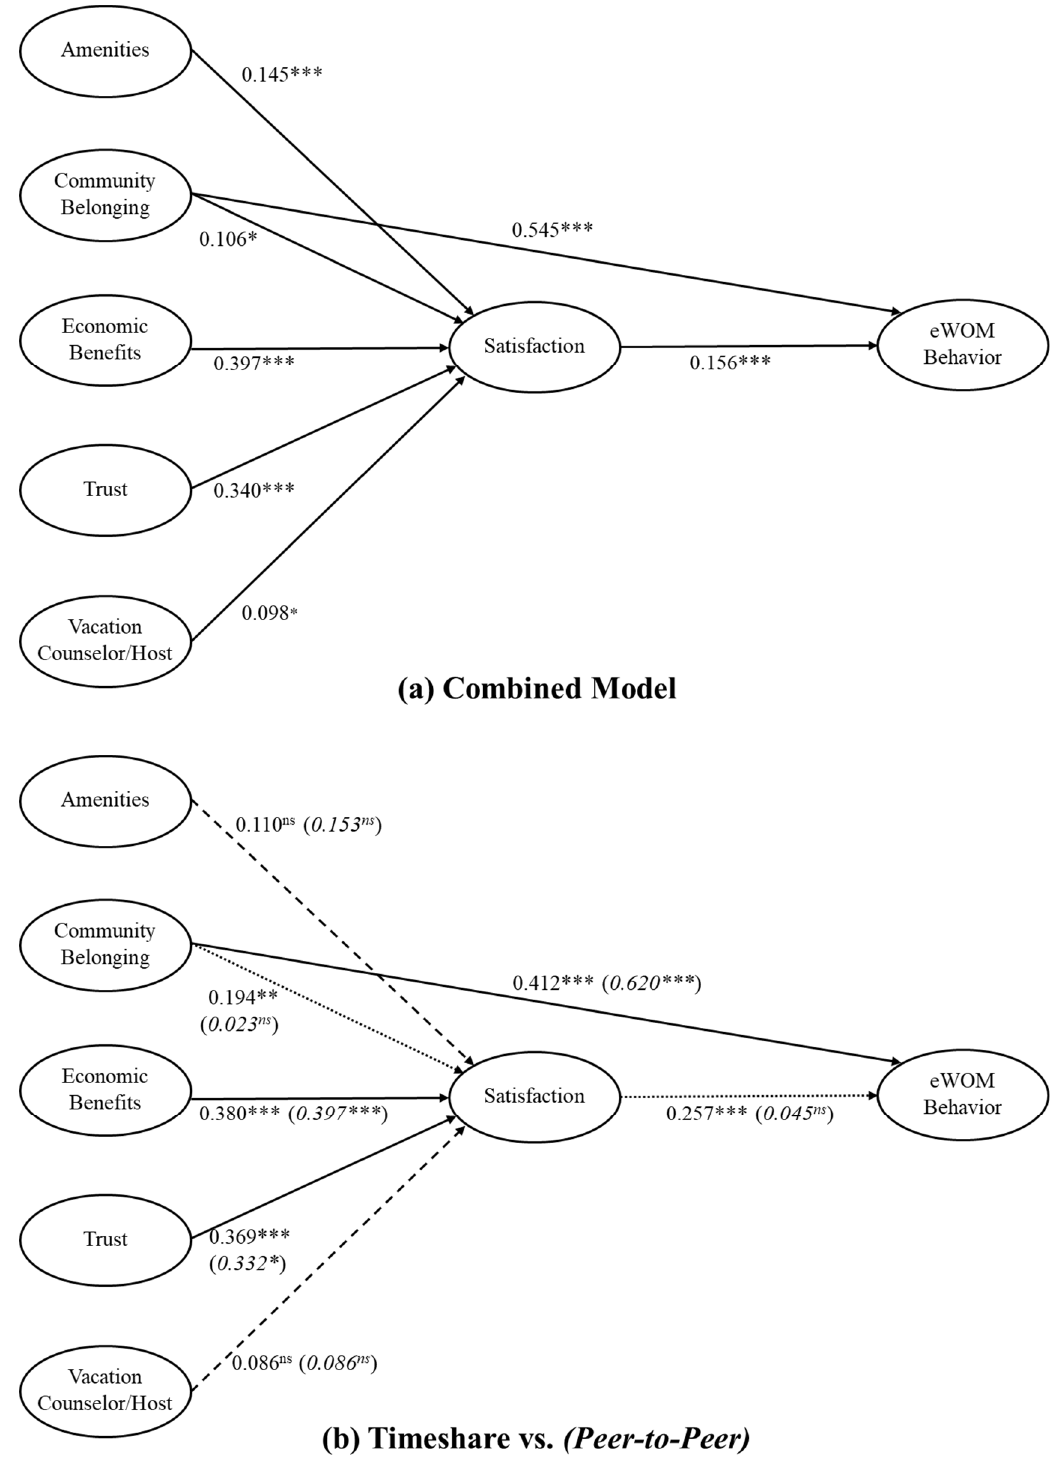
Figure 2. Structural model results. Notes: Standardized parameter estimates. Significant for both groups; Significant for timeshare only; for both